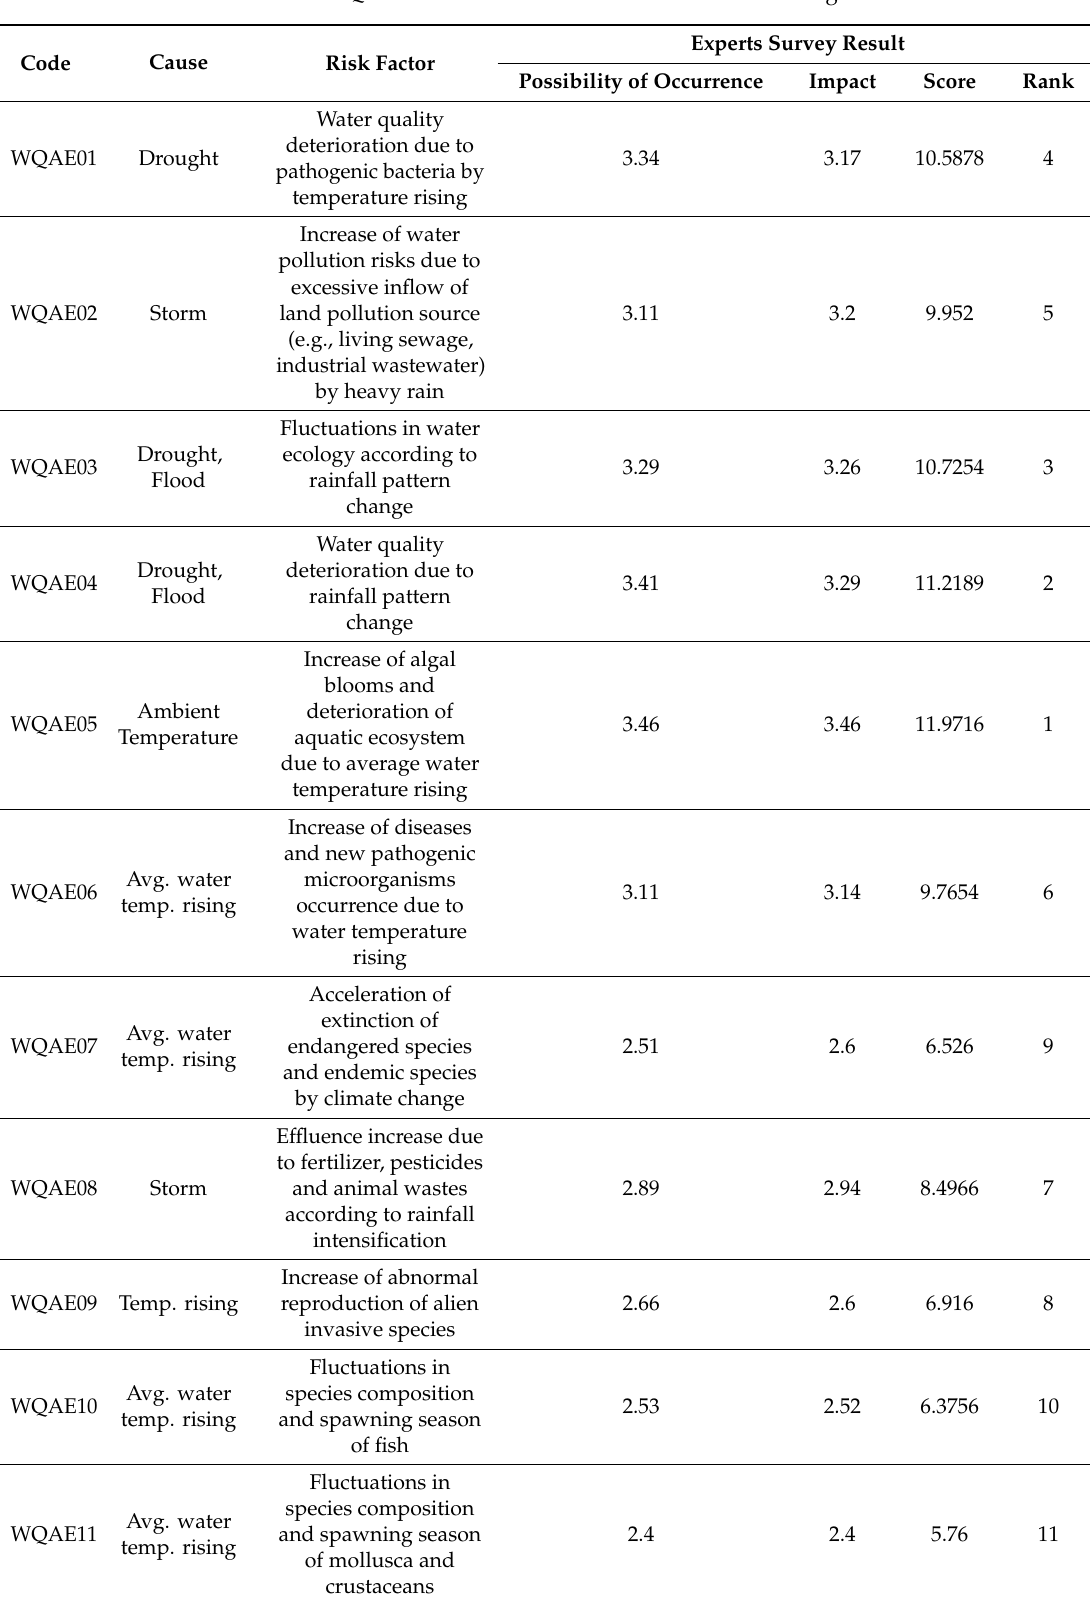
Table A3. WQA risk factors and assessment result of